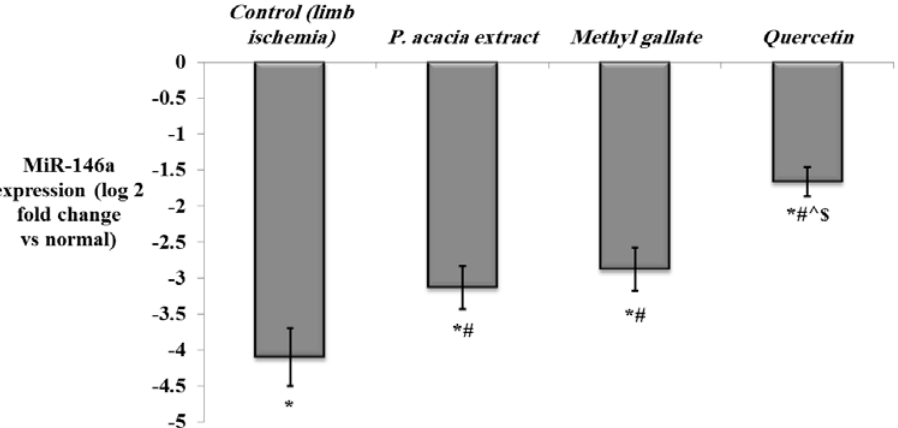
Figure 9. The effect of the P. acacia extract and its isolated compounds (methyl gallate and quercetin) on the expression levels of miR-146a in the hind limb tissue of the experimental rats. ( n = 8). Data are expressed as mean ± SD of the log 2 fold change relative to the normal group (log 2 (1) = zero, i.e., base line). Data were analyzed using one-way ANOVA followed by Bonferroni’s post hoc test. * Significantly different compared to the normal group, # significantly different compared to the hind limb ischemia control group, ˆ significantly different compared to the group treated with the P. acacia extract, $ significantly different compared to the group treated with methyl gallate. Values were considered significantly different at p < 0.05.